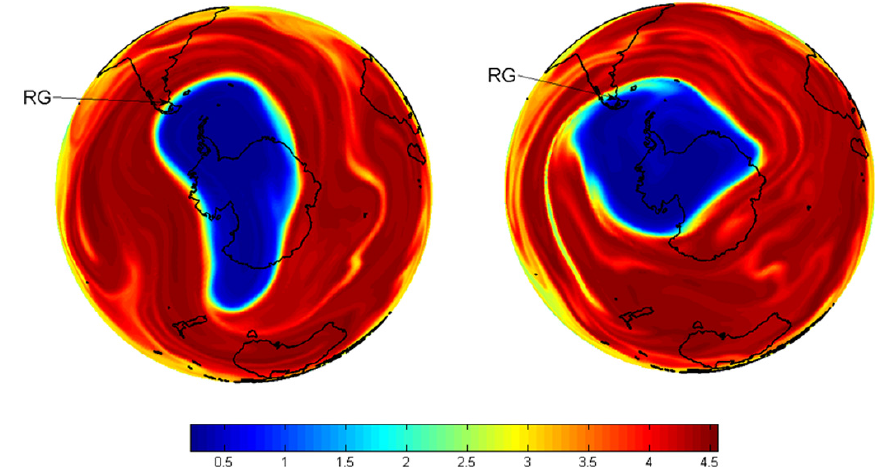
Fig. 10. Polar orthographic projection of ozone volume mixing ratio (in ppmv) at 500K calculated by MIMOSA-CHIM. Left side corresponds to 13 November and rigth side corresponds to 24 November at 12:00UTC. R ´ ıo Gallegos position is indicated with the RG